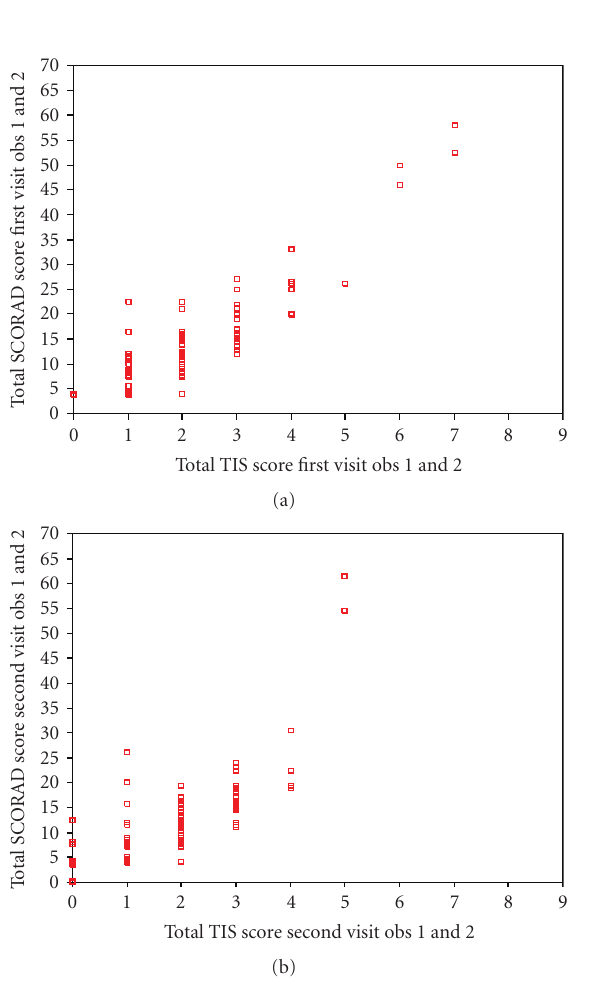
( r s from 0.197 to